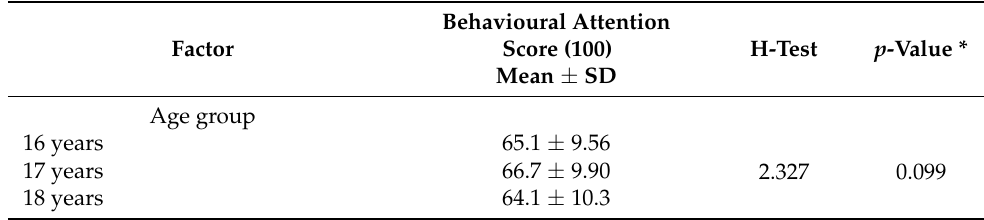
Table 5. Association between the behavioural attention scale and the sociodemographic characteristics of the participants ( n =